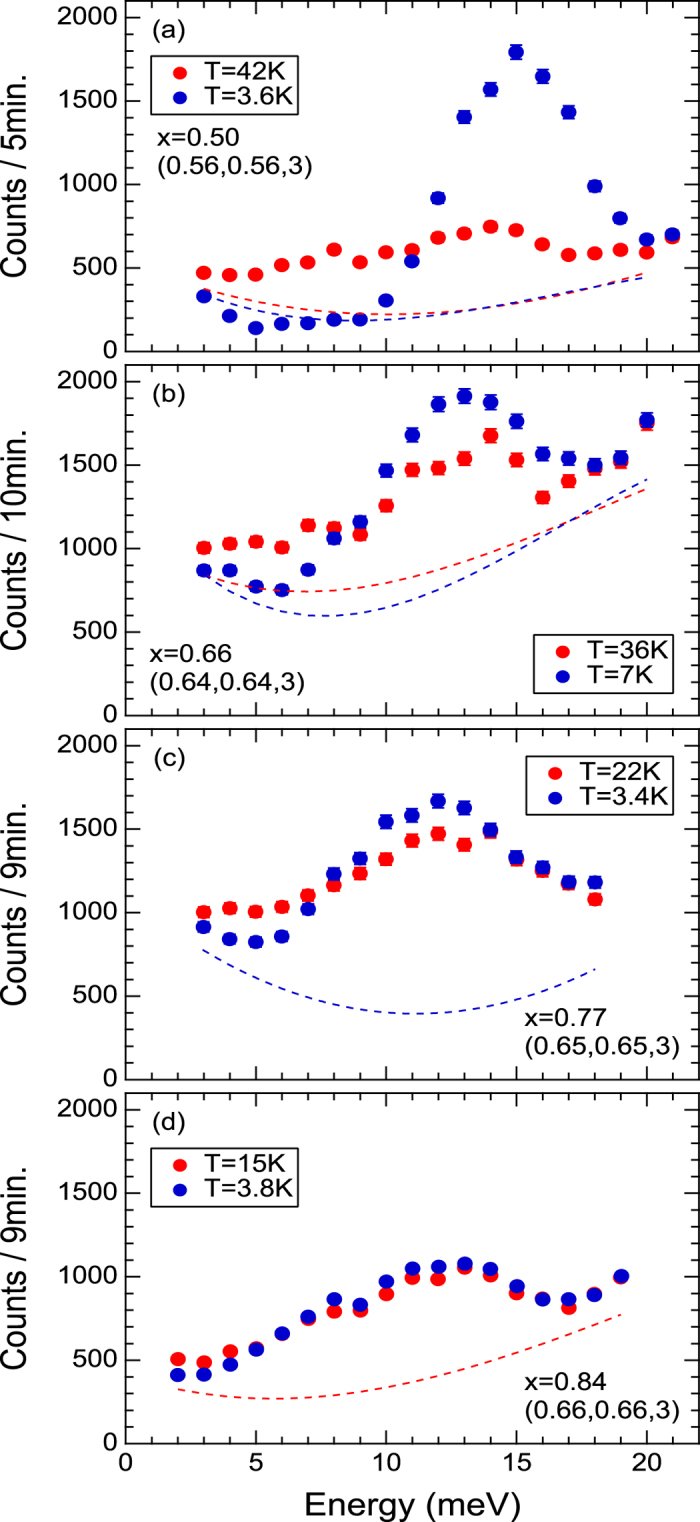
Energy dependences of magnetic signals at Q = (0.5 ± δ, 0.5 ± δ, 3) at T ~ Tc and T < Tc for (a) x = 0.50, (b) x = 0.66, (c) x = 0.77 and (d) x = 0.84. Dashed lines describe the background at T ~ Tc (red) and T < Tc (blue) determined by averaging the background at (a) (0.28, 0.28, 4), (0.72, 0.72, 3) and (0.695, 0.695, 0); (b) (0.48, 0.48, 3.65), (0.22, 0.22, 3) and (0.78, 0.78, 3); (c) (0.2, 0.2, 4.29) and (d) (0.5, 0.5, 3.69). Because Tc is sufficiently low for x ≥ 0.77 samples, their backgrounds should be almost temperature-independent below Tc.